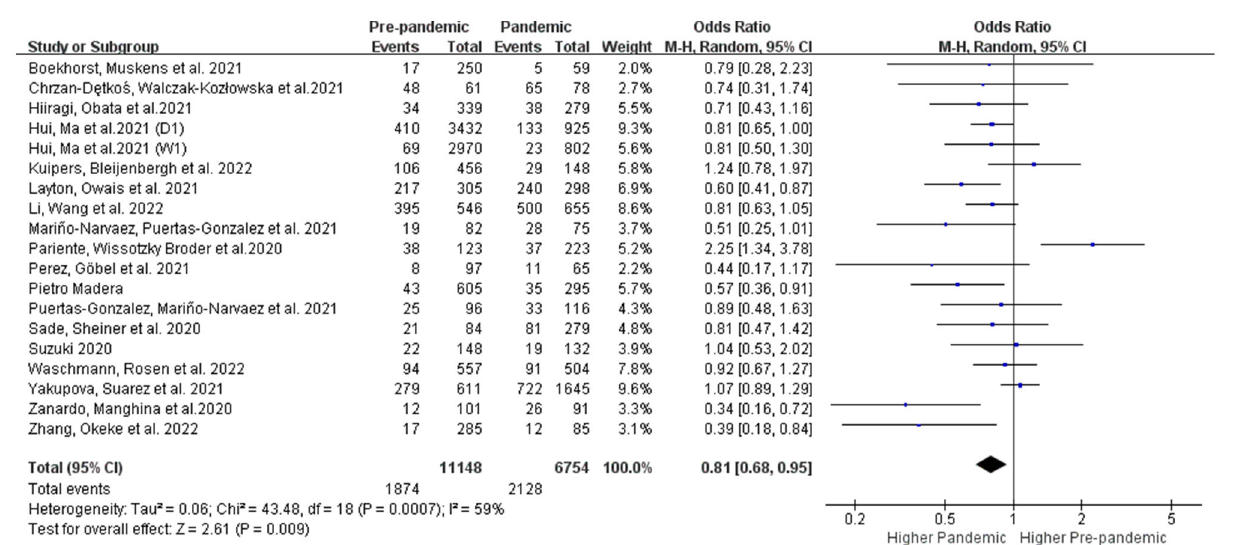
it can last year’s (46, 47). Further subgroup analysis with different follow-up times was performed. Results showed that the prevalence of PPDS within 2 weeks of delivery showed no change before and during the COVID-19 period (OR: 0.81 [0.55, 1.19], P = 0.28, I 2